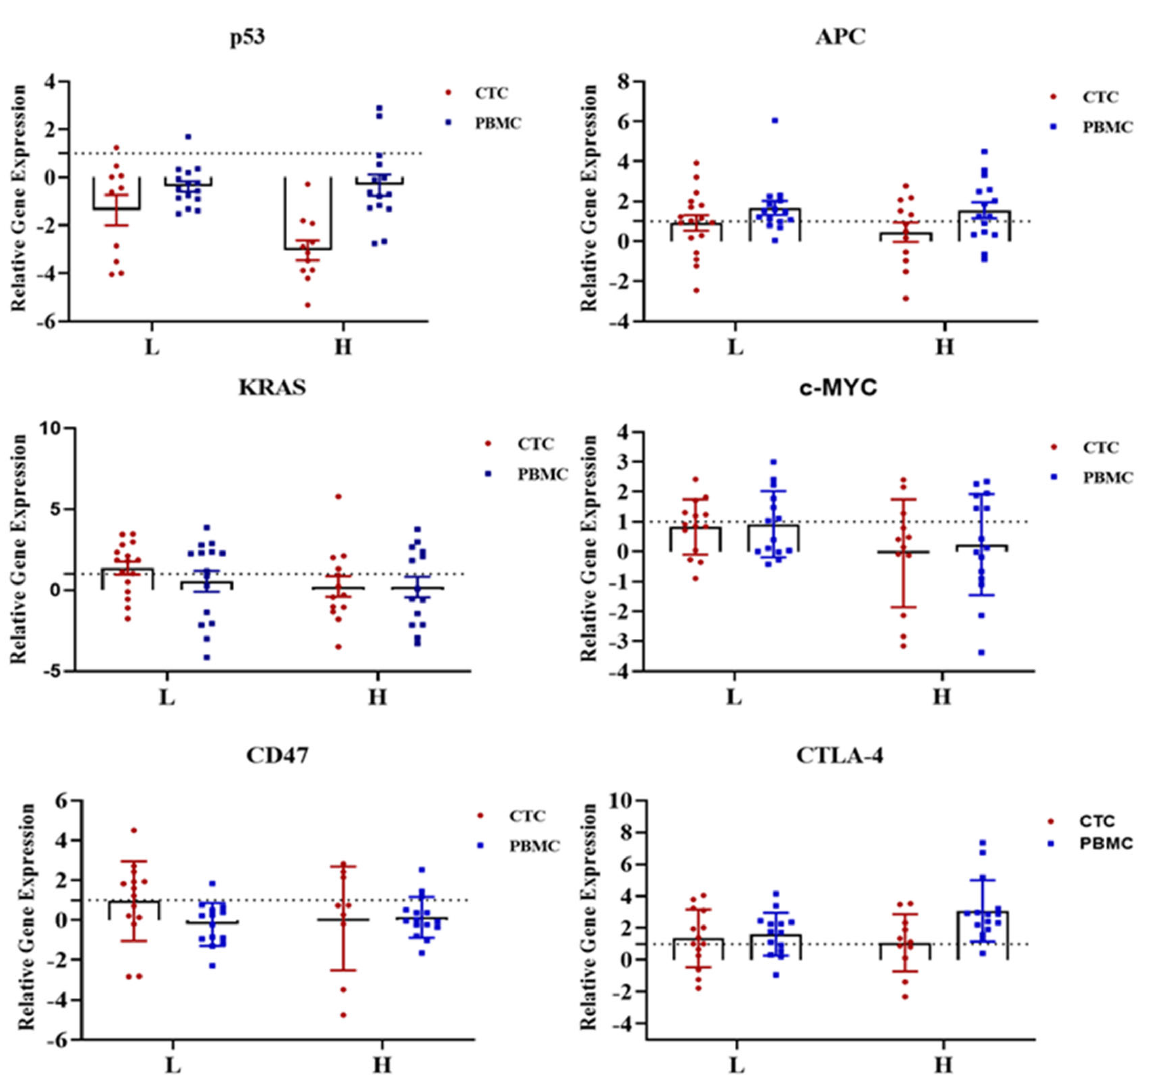
Figure 3. Comparison of the gene expression of oncogenes ( KRAS , c-Myc ), tumour suppressor genes ( p53 , APC ) and immune checkpoint molecules ( CTLA-4 , CD47 ) between high versus low CTC-positive groups in CTCs and PBMCs from patients with colorectal carcinoma (CRC). Data are depicted as scatter plots interleaved with bar plots, indicating min. to max. value. All the values are plotted as mean ± SEM. The dashed line indicates the normal fold change value. The PCR data were shown on a log2 scale and analysed by unpaired two-way ANOVA (Bonferroni’s multiple comparison test). Comparisons were considered significant at p ≤ 0.05.